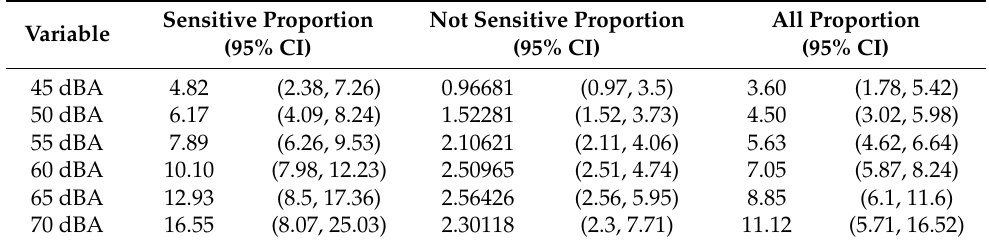
Table A13. L Night and marginal proportions of sleep disturbance by transportation noise in the weighted study sample, adjusted for sensitivity to noise: marginal prediction by sensitivity.